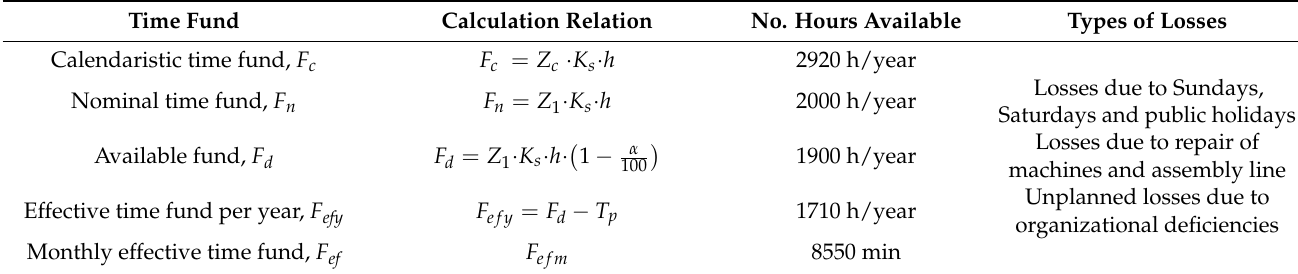
Table 2. Determination of the annual and monthly effective time fund for one shift.